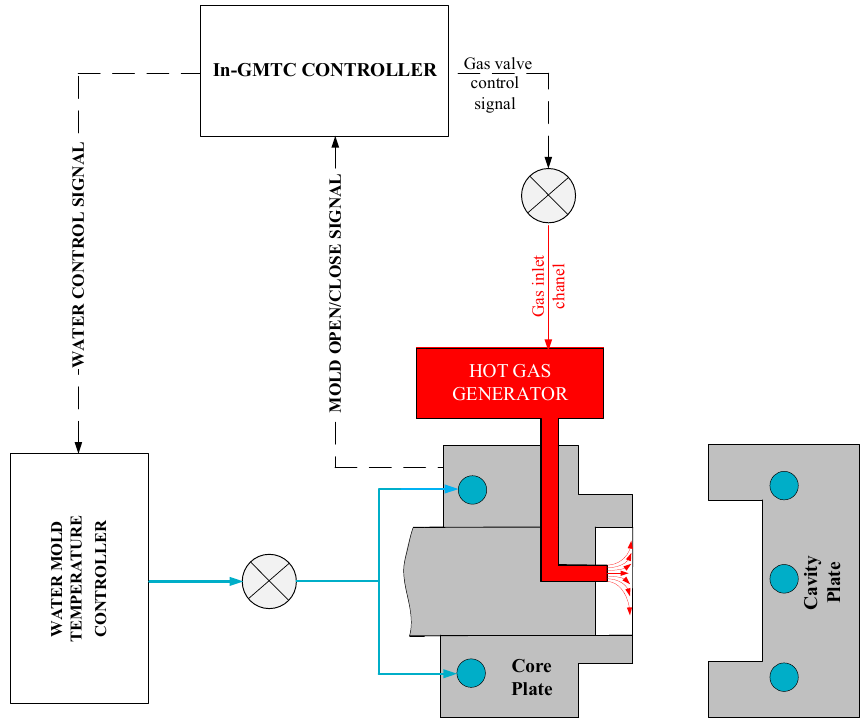
Figure 1. The internal gas-assisted mold temperature control (In-GMTC) system.